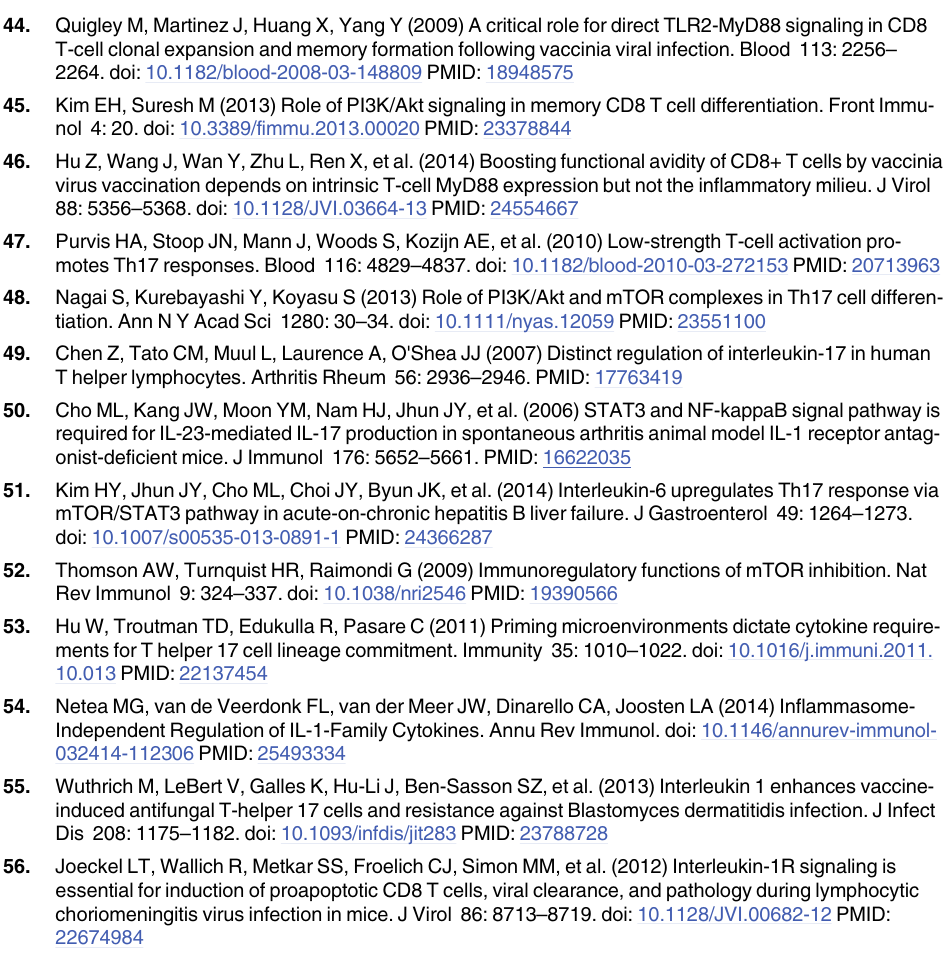
PLOS Pathogens | DOI:10.1371/journal.ppat.1005161 September 14,